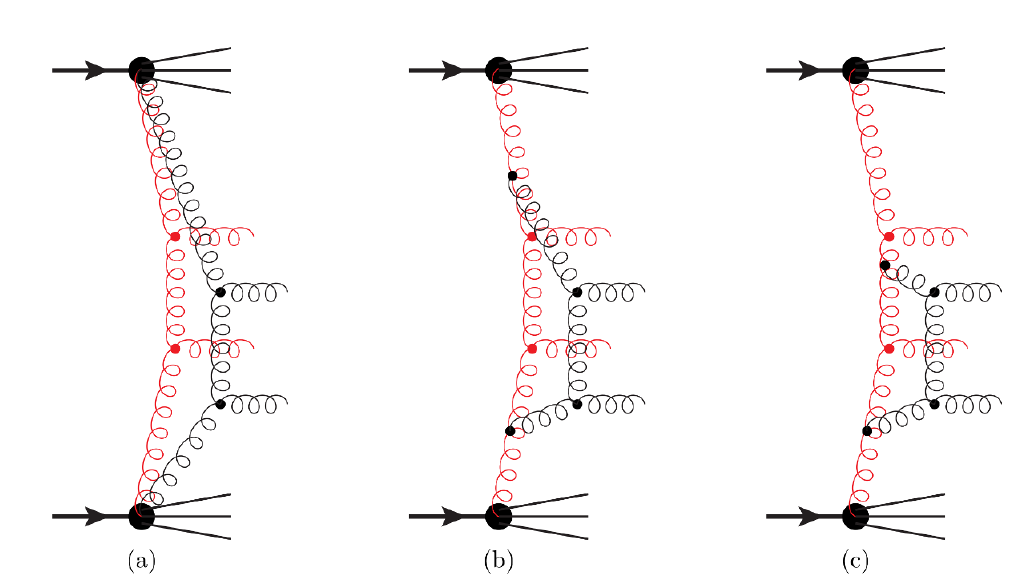
Figure 2 . Schematic pictures of multi-parton interactions in a pp collision. The y -axis should be interpreted as rapidity. All initial- and (cid:12)nal-state radiation has been removed to avoid cluttering. Each gluon should be interpreted as having two colour lines associated with it, which in the subse- quent string hadronisation will contribute to the soft multiplicity. In (a) the colour lines for both sub scatterings stretches all the way out to the proton remnants, while in (b) and (c) the secondary scattering is colour-connected to the primary